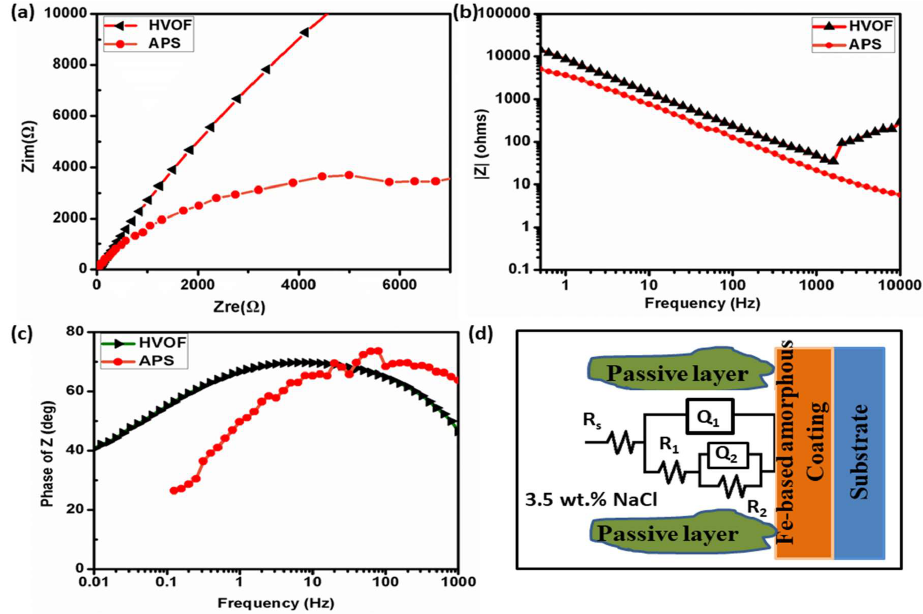
Figure 5. The electrochemical test results of SAM1651 in 3.5 wt.% NaCl aqueous solution, coated by APS and HVOF. ( a ) Nyquist plot for APS and HVOF. ( b ) Bode plot. ( c ) Phase of Z (deg.) for APS and HVOF. ( d ) General model of the equivalent circuits proposed to carry out curve fitting for the EIS data from the Zsim 3.20 software.